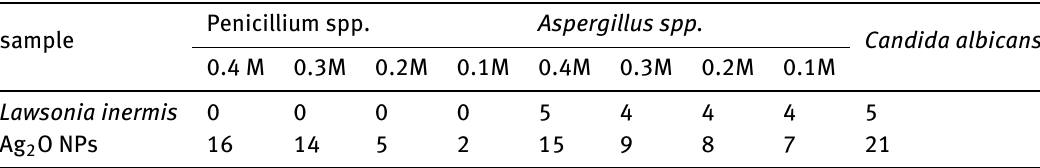
Table 2: Antifungal inhibition zone diameter of henna plant extract and Ag 2 O NPs against Penicillium spp., Aspergillus spp., and Candida albicans